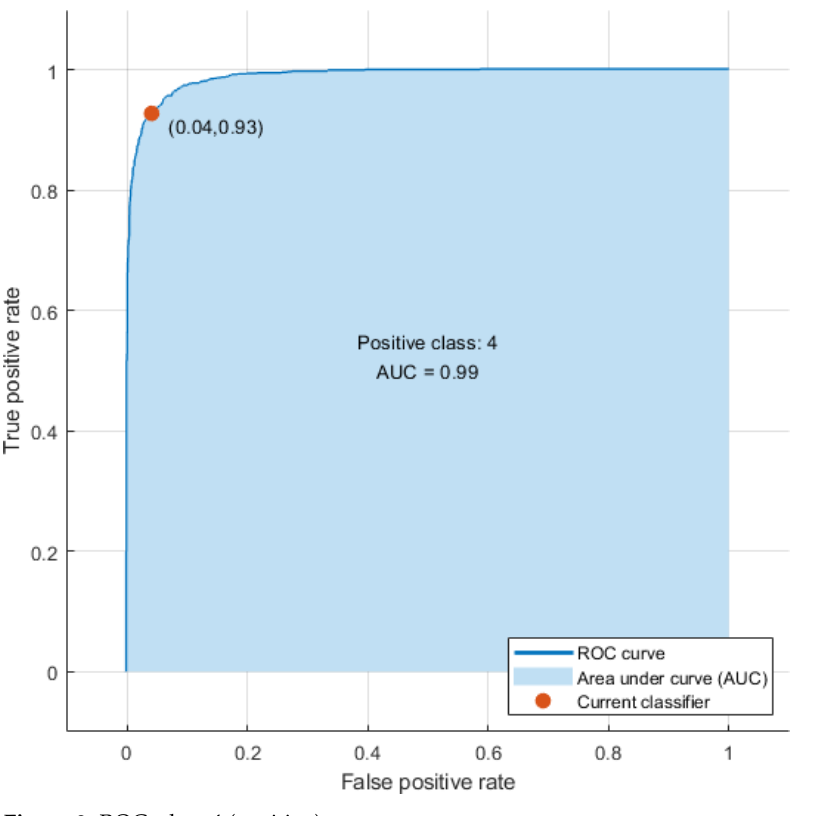
Figure 9. ROC: class 4